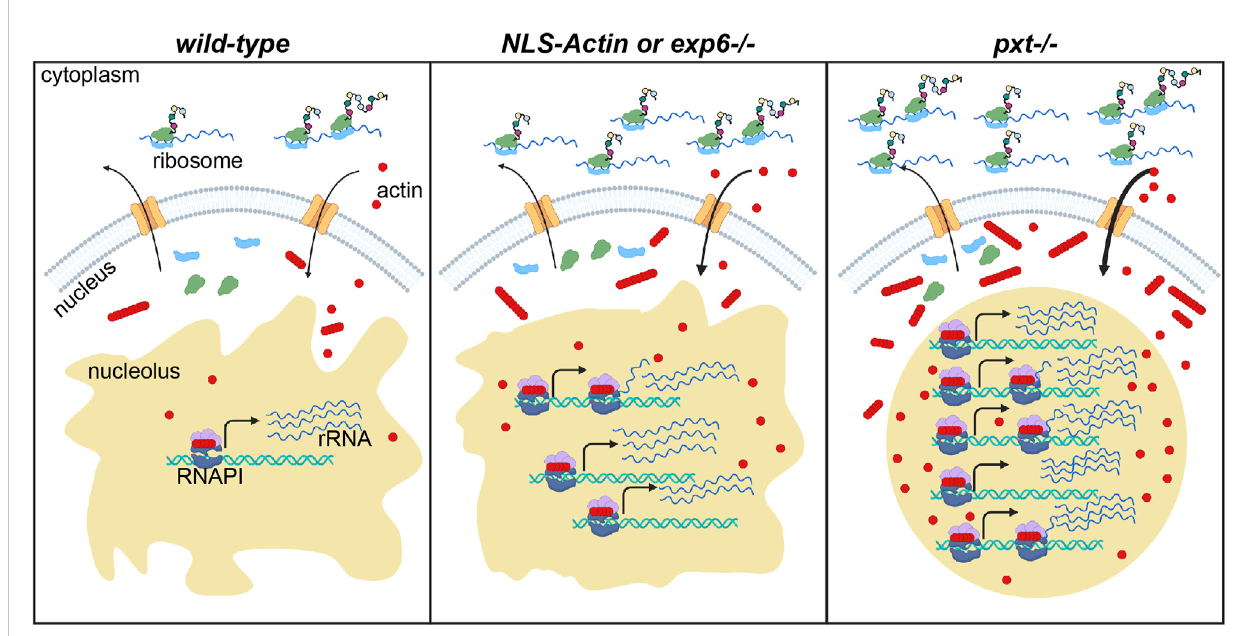
FIGURE 8 Nuclear actin levels must be tightly regulated to coordinate nucleolar activity with development. Schematic of the resulting model for how nuclear actin levels and/or form correspond to the level of rRNA transcription and protein translation in wild-type, increased nuclear actin (NLS-Actin overexpression or Exportin 6 [Exp6] loss), and pxt mutant contexts. The cytoplasm (top) and nucleus (bottom) are diagramed for a single cell in each context. Nuclear envelope = gray, nuclear pores = orange; nucleolus = tan; RNAPI complex: polymerase = dark blue, regulatory factors = light purple, ribosomal DNA (rDNA) = teal helix, rRNA = blue lines; actin (monomers and polymers) = red circles and lines of red circles; ribosomal subunits = light green and light blue; nascent proteins = colored circles on black lines emerging from ribosomes. In wild-type follicles, tight regulation of nuclear actin maintains the correct levels of monomeric and polymeric nucleolar actin to ensure correct rRNA production, a tubular nucleolar structure, and normal ribosome biogenesis and protein translation levels. When nuclear actin levels are slightly increased, by expression of NLS-Actin or loss of Exp6, there is increased nuclear and nucleolar actin, a modest change in nucleolar structure, and increased rRNA production. When Pxt is lost, nuclear actin levels increase and the form of nuclear actin is altered; this results in increased rRNA production, a rounding of the nucleolus, increased ribosome biogenesis (predicted but not tested) and increased protein translation